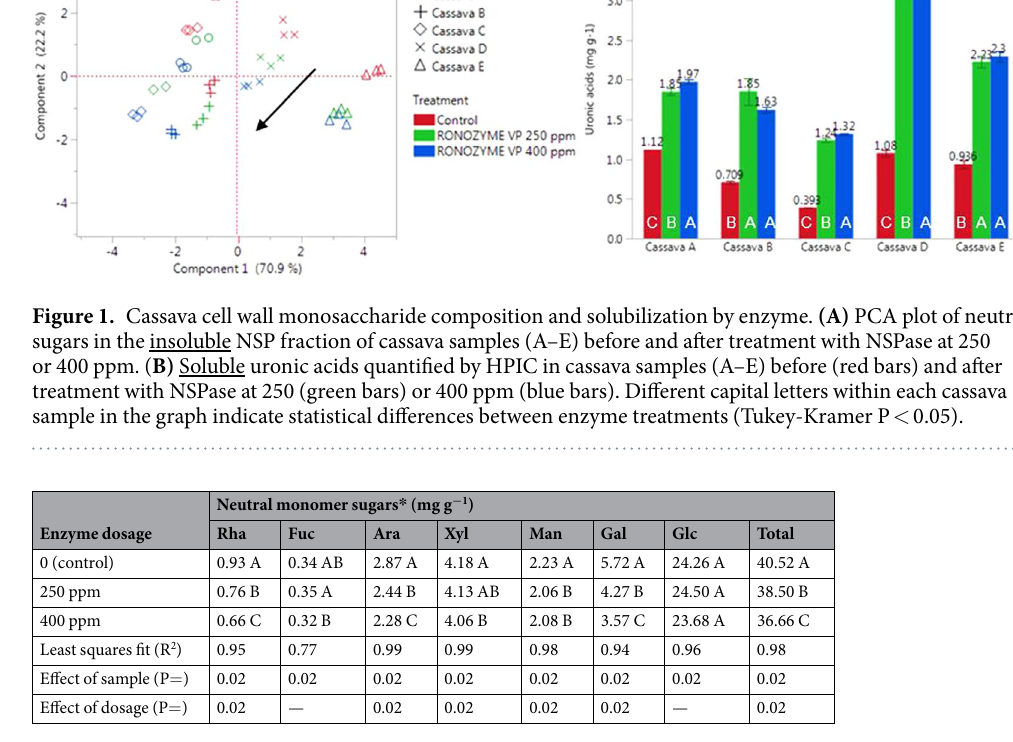
Table 3. Enzyme effect on the cell wall polysaccharide content in cassava samples. Neutral sugar content of the insoluble NSP fraction of five cassava samples before and after treatment with the commercial NSPase Gal = galactose, Glc = glucose. ABC: Different capital letters indicate that values within the same column are statistically different (Tukey-Kramer P <